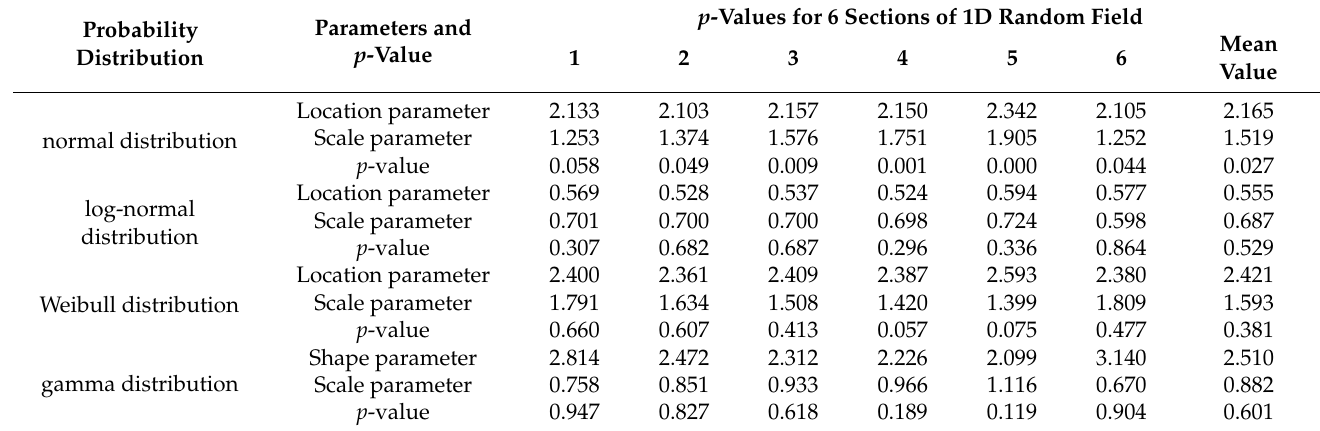
Table 2. Pointwise parameters estimation for the nano-hardness of the ITZ.